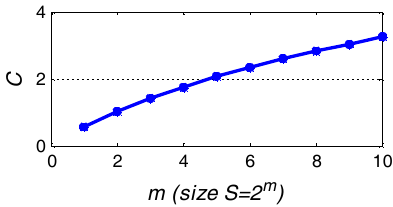
Figure 4. The expected value C of the maximum individual from samples of size S = 2 m , in which the samples are standard normal random variables .